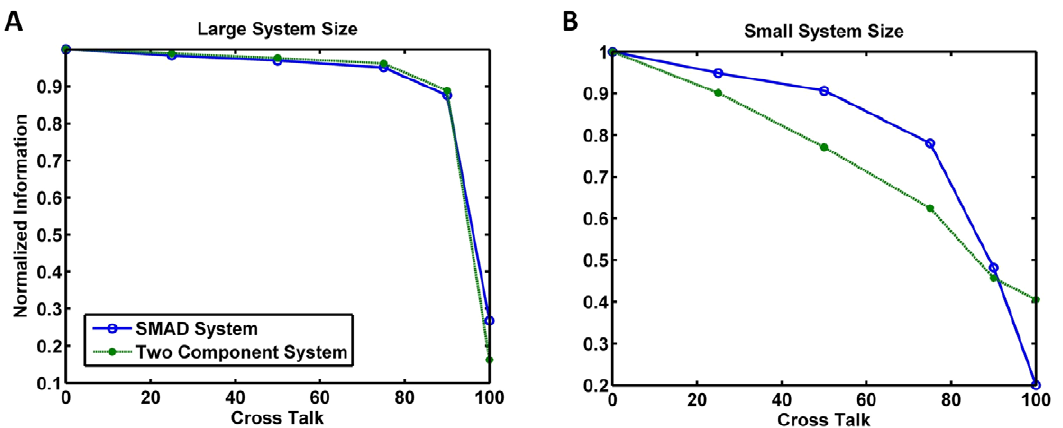
Figure 9. Information in bits vs. symmetrically varying cross-talk, a comparison of the effects of system size and the mode of phosphotransfer. (A) The Smad system and the two-component system for large system sizes (B) the Smad systems and the two-component system for small system sizes.